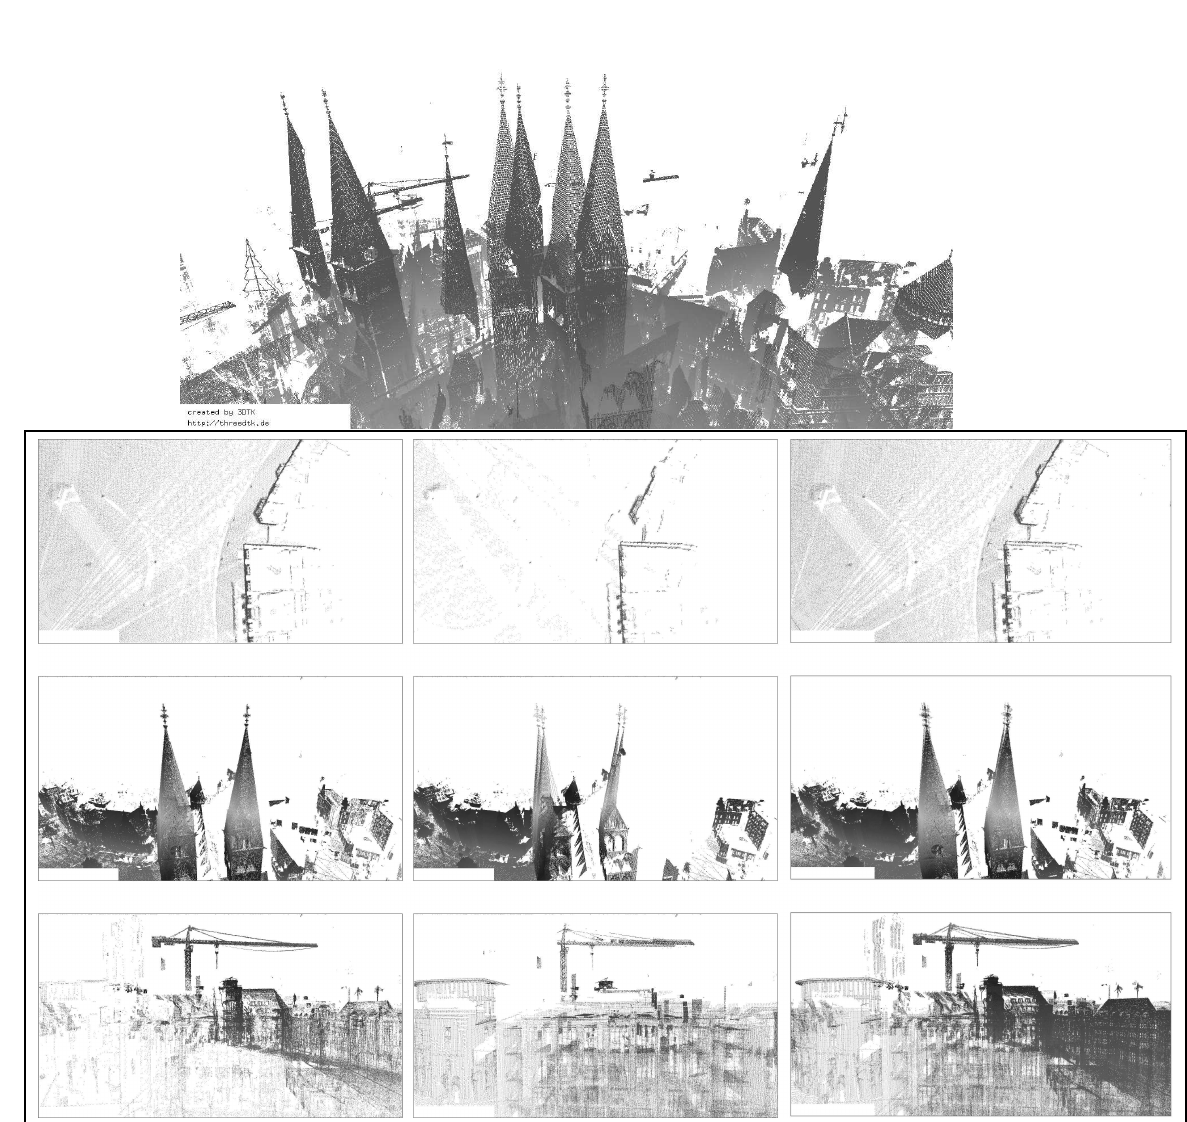
Figure 5. Above: Non-registered input 3D point clouds. Below: Left column contains images created using the original global relaxation without pose fixing, middle column contains images taken from the same position with algorithmic pose fixing, right column contains images with mathematical pose